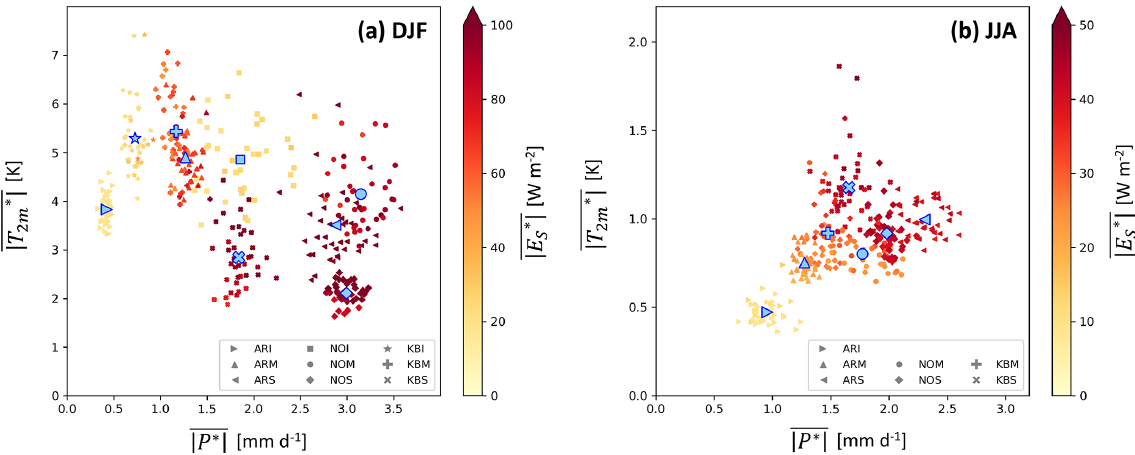
Figure 4. Seasonal-mean absolute anomalies of P ( | P ∗ | ; mmd − 1 , along x axis), T 2m ( | T 2m ∗ | ; K, along y axis) and E S ( | E S ∗ | ; Wm − 2 , color) for 39 seasons and (a) nine sub-regions in DJF and (b) seven sub-regions in JJA. Blue symbols mark average values for each sub-region.